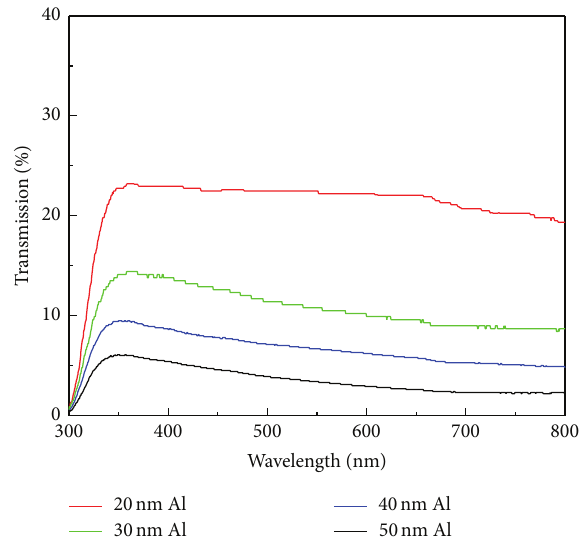
Figure 2: The transmission spectrum of the Al electrodes with thicknesses of 20 nm, 30 nm, 40 nm, and 50 nm.